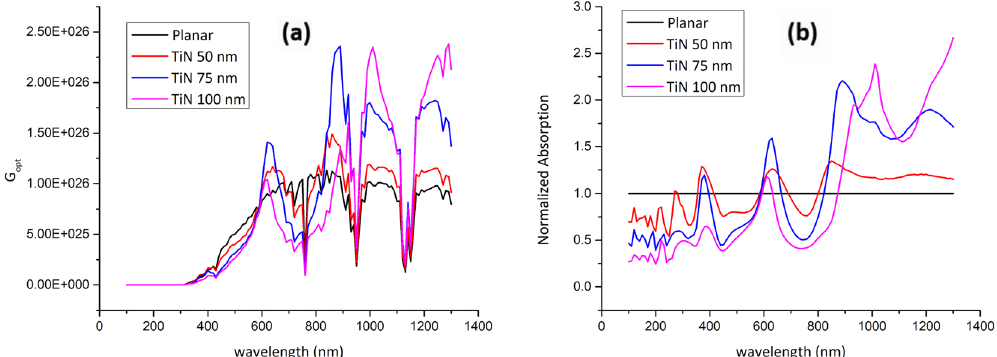
Figure 4. ( a ) Optical carrier generation rate ( G opt ) and ( b ) normalized light absorption profiles for planar and TiN-decorated PSCs.